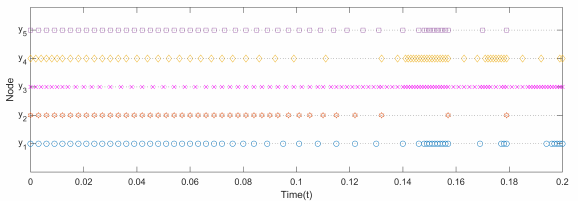
Figure 7. Event − triggered instants on node y i under condition (9).